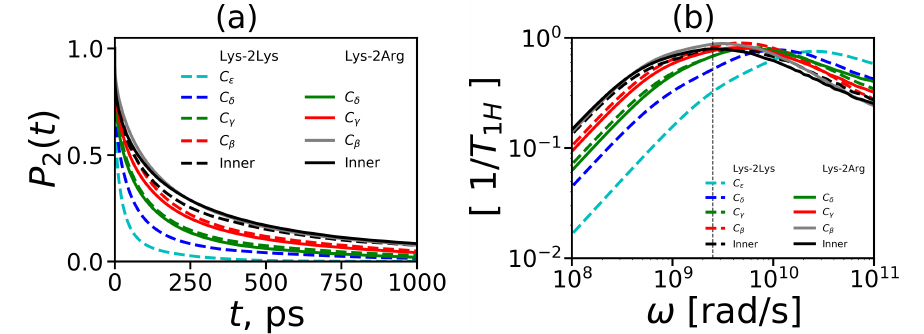
Figure 12. ( a ) The 2nd order ACF P 2 ( t ) and ( b ) the frequency dependencies of [ 1/ T 1 H ] in the susceptibility representation for H-H vector in the inner and the different types of CH 2 groups in side segments at T = 310